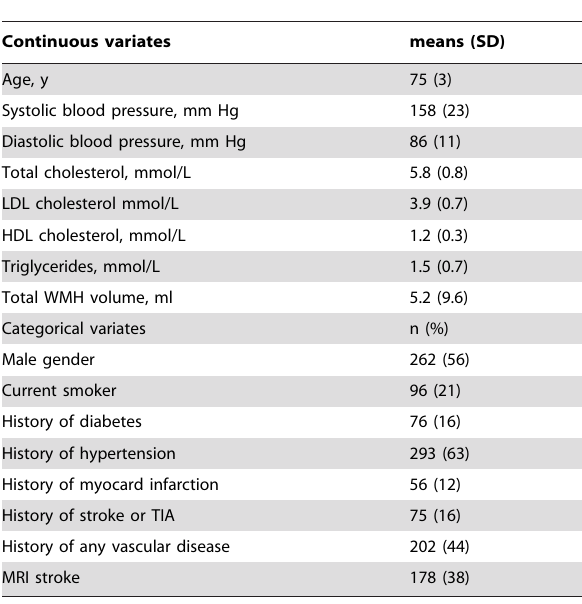
Table 1. Demographic and clinical